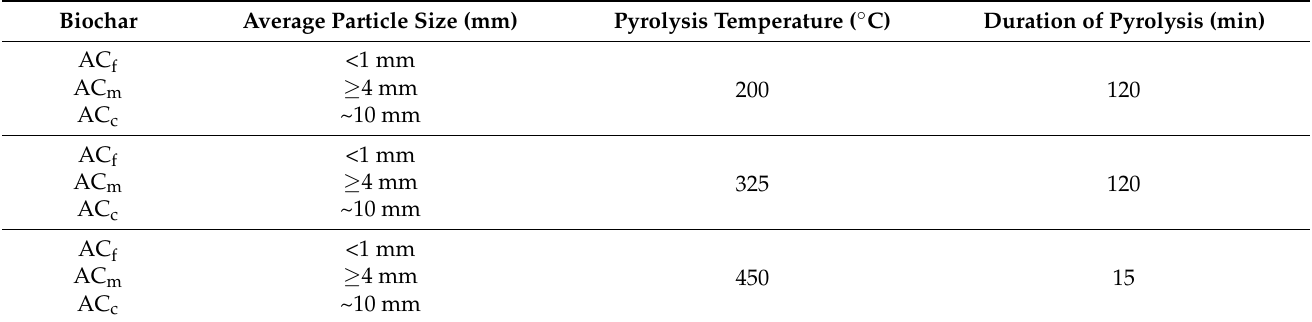
Table 1. Nomenclature of the used biochars, their production temperatures and retention